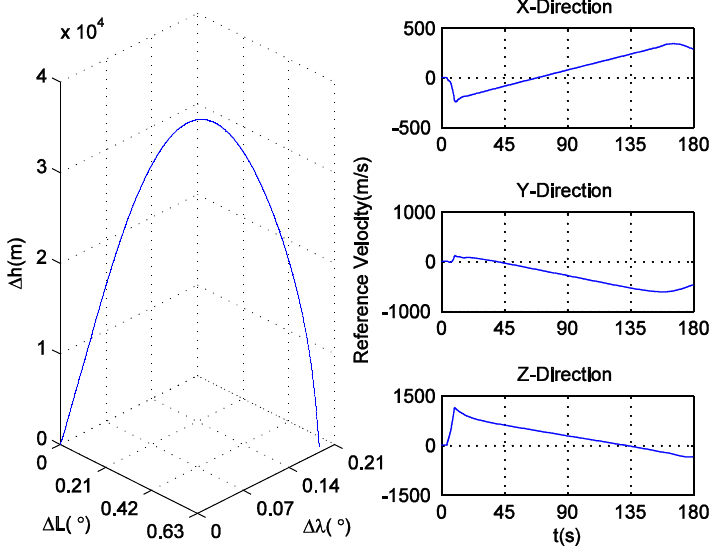
Figure 9. The reference trajectory for simulation.